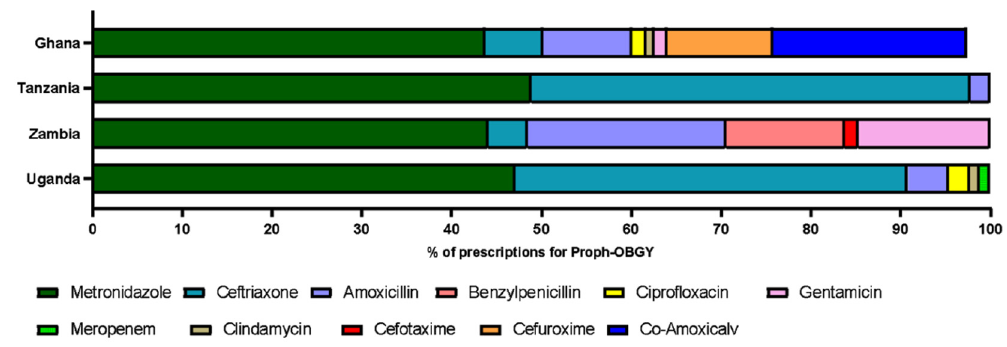
Figure 3. Antimicrobials prescribed for Prophylactic OBGY purposes in four countries (% of total). For Ghana, antimicrobials making up < 1% of prescriptions have been omitted for clarity.